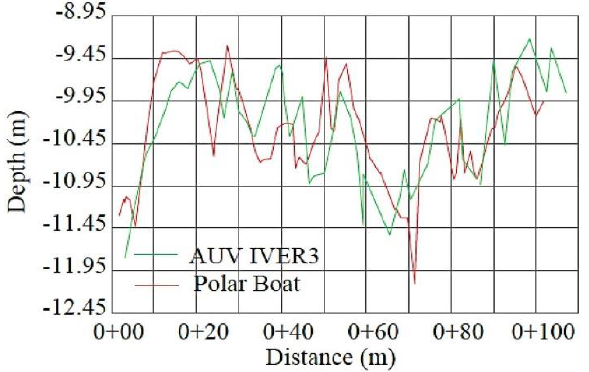
Figure 13. The Third Profile of the Second Study Area